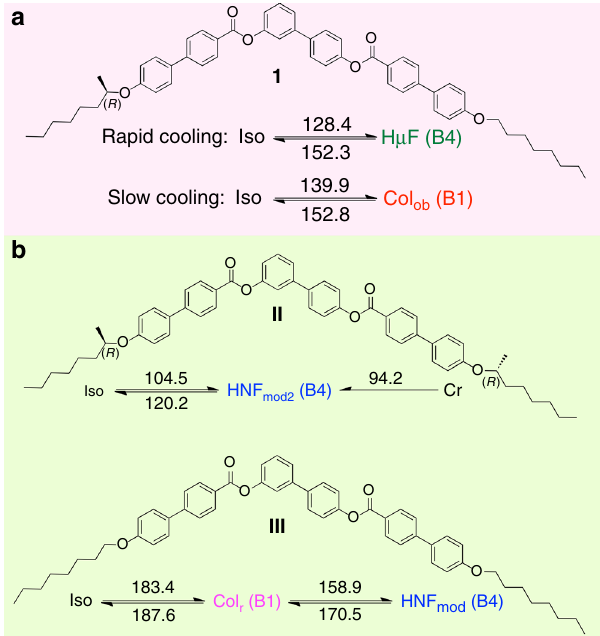
Fig. 2 Materials and phase transition temperatures. Chemical structure of a compound 1 and b the two parent bent-core liquid crystal compounds II and III 11 with their respective phase sequences and transition temperatures in ° C (determined by DSC measurements, peak values from 2 nd heating and cooling run,